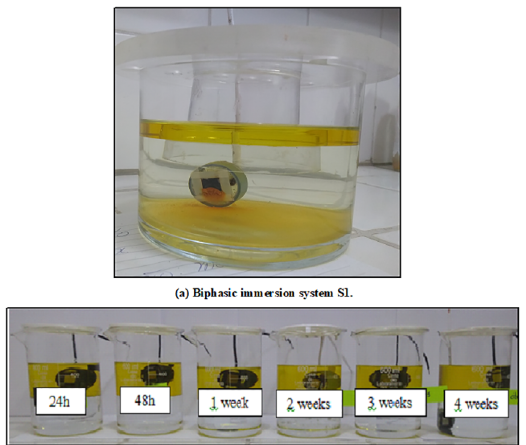
Figure 2. (a) Biphasic immersion system S1, diesel oil S10 / saline water in NaCl 3.5 wt.%, with sample immersed in aqueous solution; (b) Biphasic immersion system S2, diesel oil S10 / saline water in NaCl 3.5 wt.%, with sample immersed in diesel